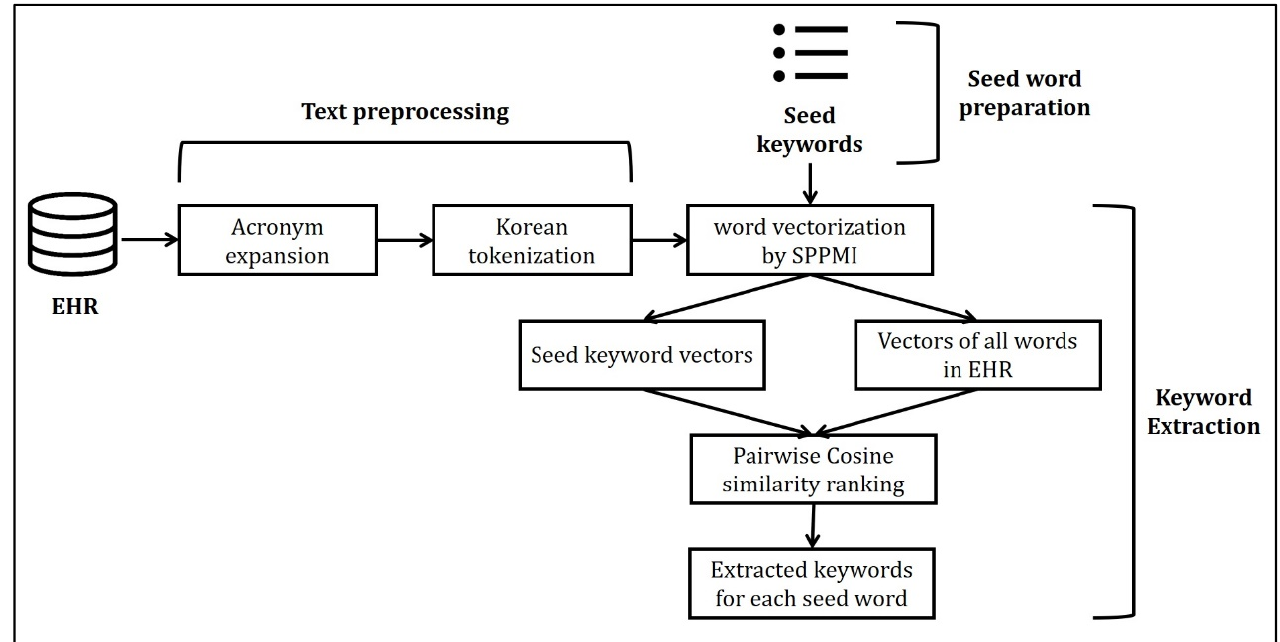
Figure 1. Overall summary of our SPPMI-based keyword extraction method.